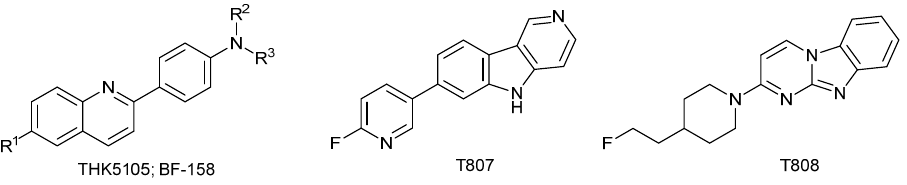
Figure 2. Molecular structures of selected heterocyclic molecular probes.